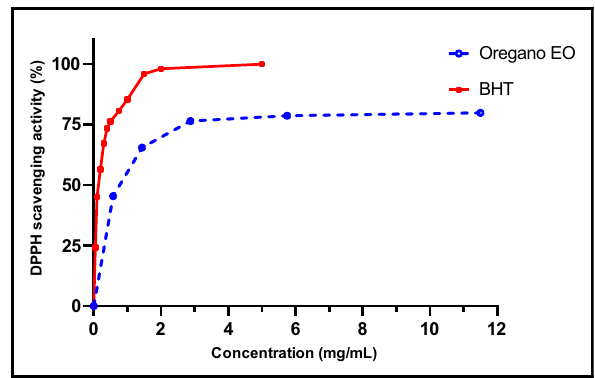
Figure 3: DPPH free radical scavenging activity of O. compactum EO and BHT.